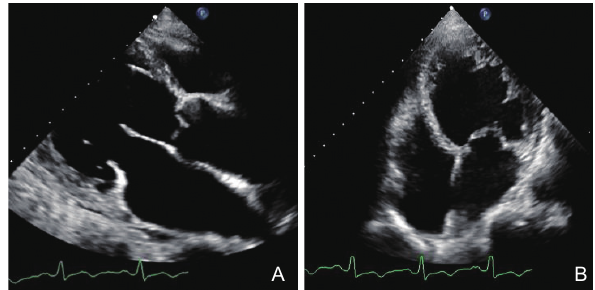
A B Figure 13 COVID-19 with cardiac abnormalities. A 73-year-old male COVID-19 patient (positive nucleic acid test, CRP: 170 mg/L, BNP: 1077 pg/mL); (A and B) significantly enlarged left heart on the parasternal long- axis view and apical four-chamber view.